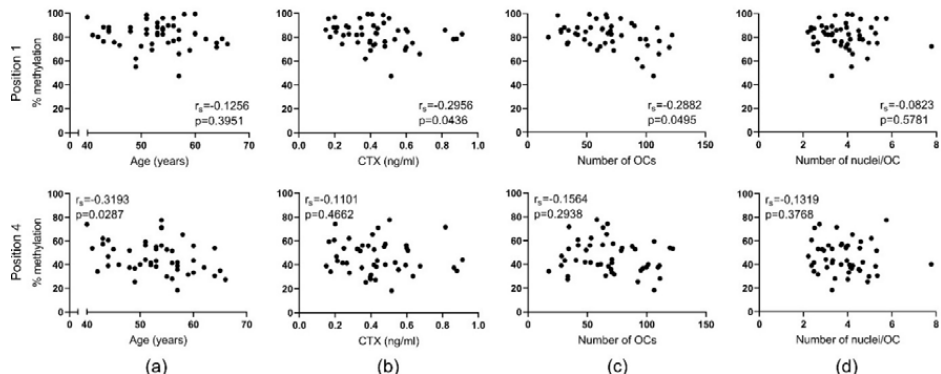
Figure 6. DNA methylation levels of single CpGs in the DCSTAMP gene decrease as donor age, bone resorption levels (CTX) in vivo, and the number of OCs in vitro increase. The relation between the level of DNA methylation of selected CpG sites in the promoter of the gene encoding DC-STAMP ( TM7SF4 ) and: ( a ) age (reproduced from: Møller et al. 2020 [17] with permission of Bone Research, published by Springer Nature, 2020), ( b ) CTX levels in vivo, ( c ) the mean number of OCs (per vision field) in vitro, and ( d ) the mean number of nuclei per OC in vitro. Statistics: correlation analyses were performed using Spearman’s rank correlation (r s ). Each point represents the results obtained from OCs generated from an individual donor ( n = 46). The selected CpG sites are indicated as “positions”. Only relevant positions out of four analyzed were selected to be shown in this figure.